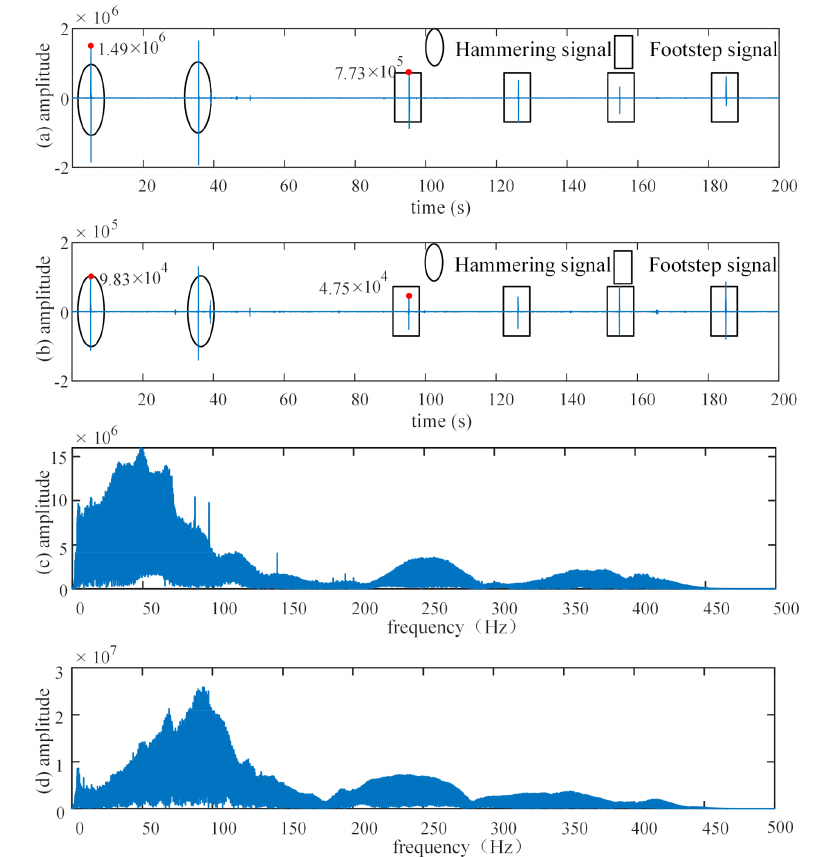
Figure 2. The comparison of hammering signals and footstep signals; ( a ) Hammer signals and footstep signals in raw data; ( b ) Hammering signals and footstep signals filtered by a 5–100 Hz band-pass filter; ( c ) The spectrum of footstep signals in raw data; ( d ) The spectrum of hammer signals in raw